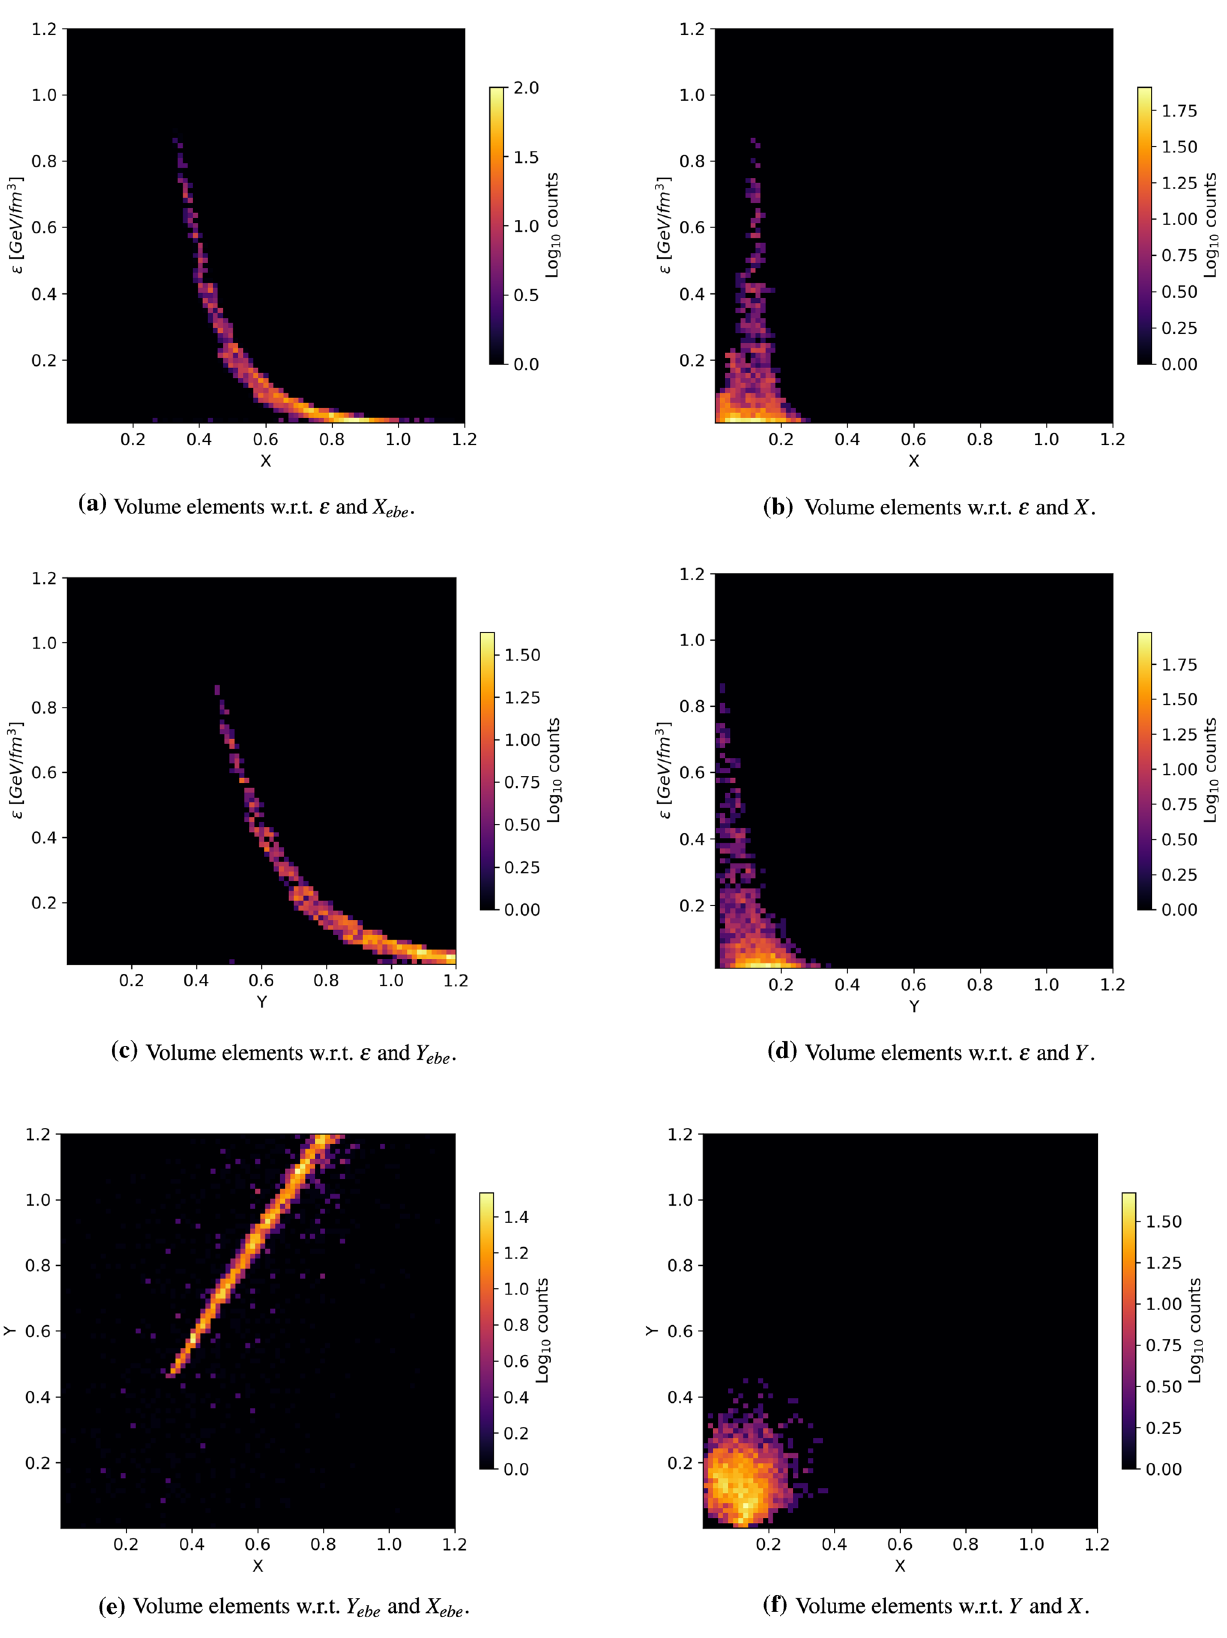
Fig. 12 2D histograms of volume elements with respect to energy density, pressure anisotropy and off-diagonality. Au+Au collisions at E lab = 1.23 AGeV, 0–5% centrality class, t = 14